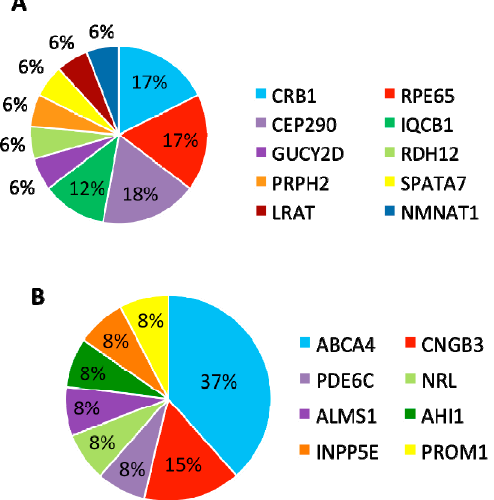
Figure 5. Distribution of genes mutated in 30 Brazilian probands solved by either canonical LCA/EOSRD genes or genes associated with other retinal diseases. ( A ) Percentage of genes with causal variants in the 17 probands solved by variants in canonical LCA/EOSRD genes. ( B ) Percentage of genes with causal variants in the 13 probands solved by variants in genes associated with other retinal diseases.